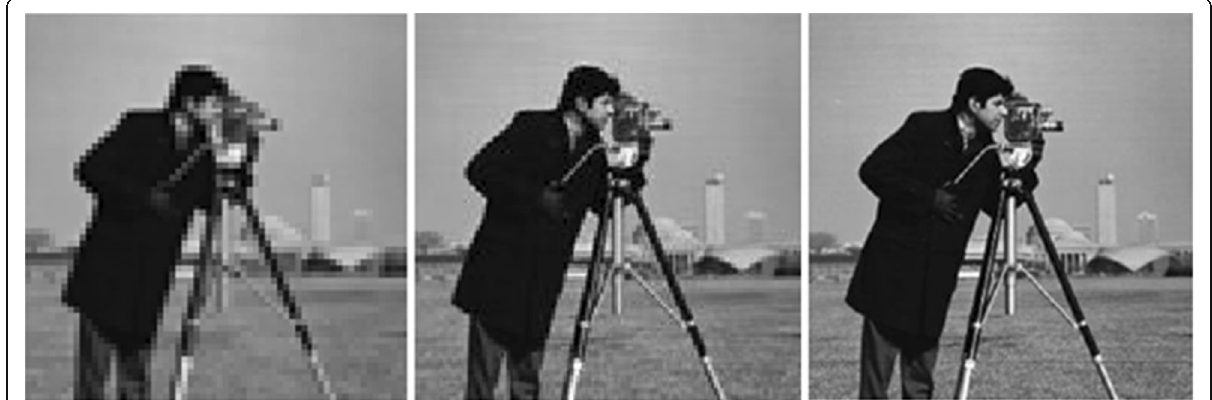
Fig. 1 Photographer images with different resolutions (the left is the 64×64 image, the middle is the 128×128 image, and the right is the 256×256